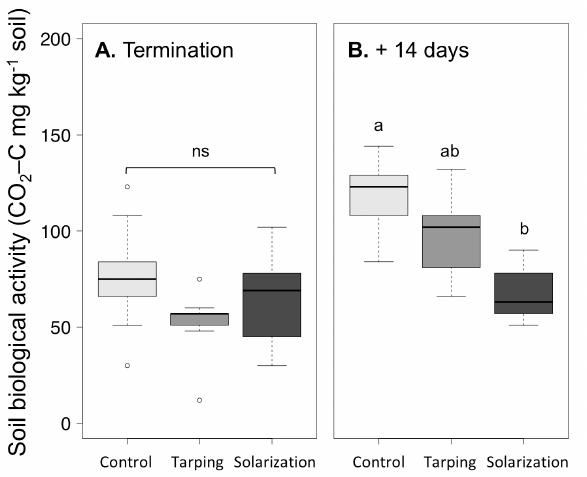
Figure 4. Soil biological activity in the TARP